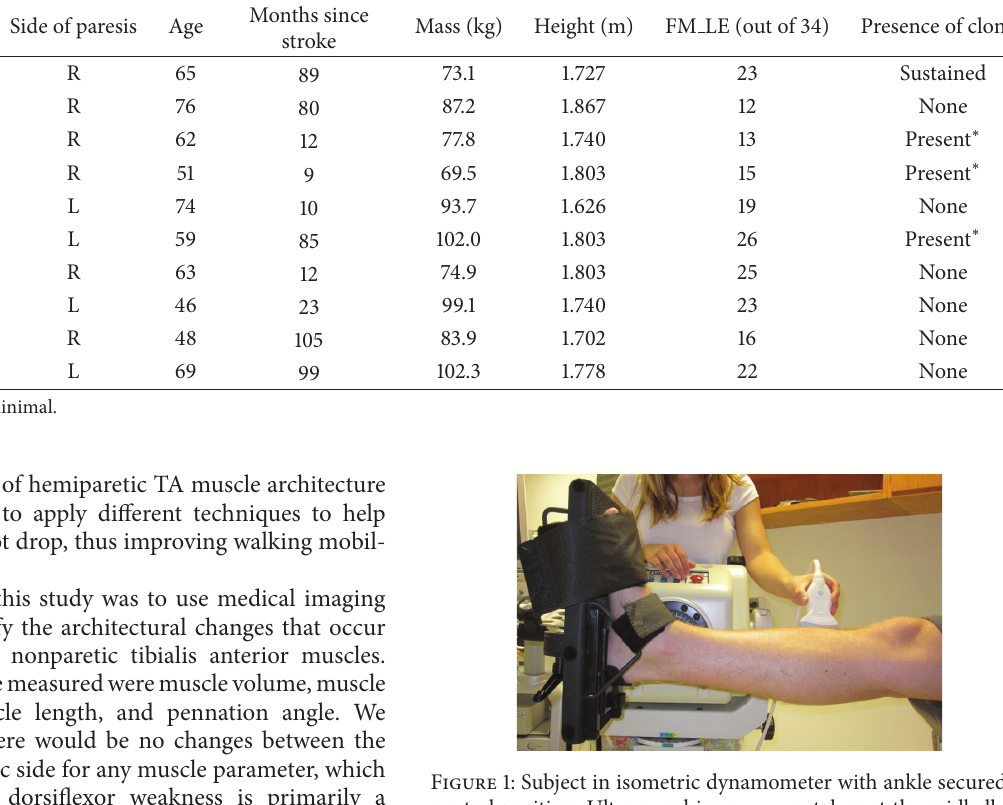
Table 1: Subject demographics for 10 poststroke individuals.